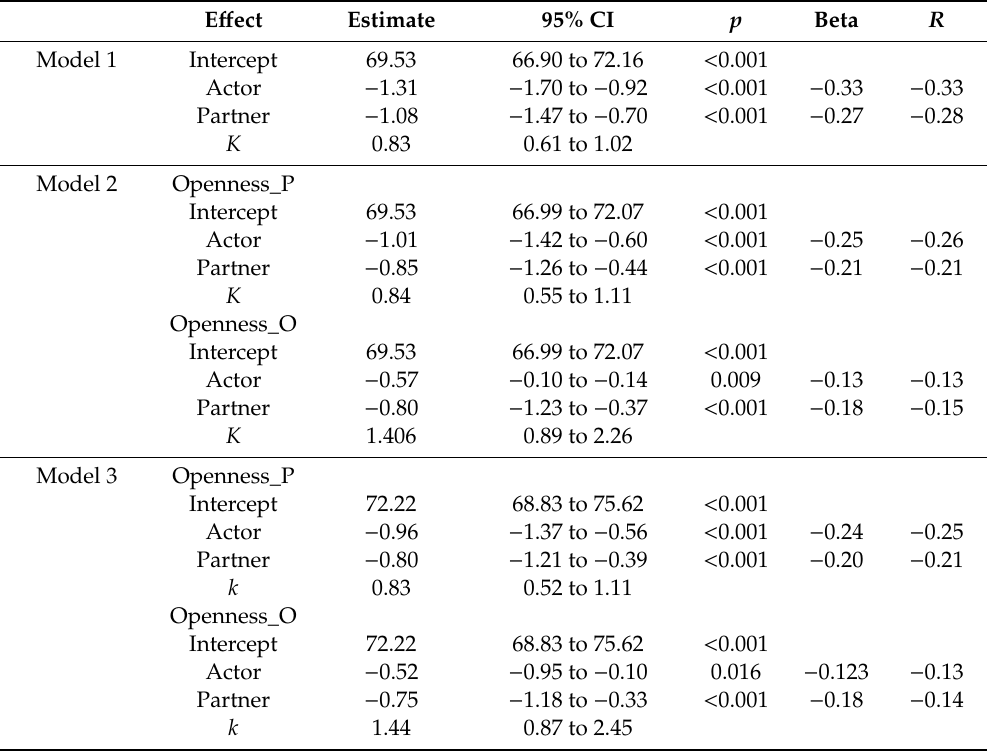
Table 3. Actor and partner e ff ects of perceived partner’s openness on marital satisfaction. E ff